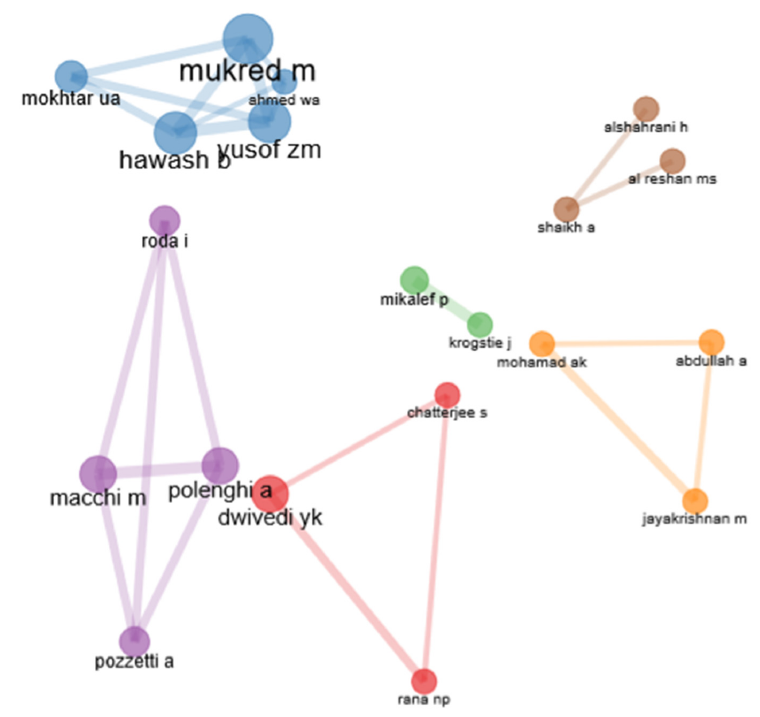
Figure 5. Author collaboration network. Table 6. Most impactful scientific articles in the field of big data analytics and information